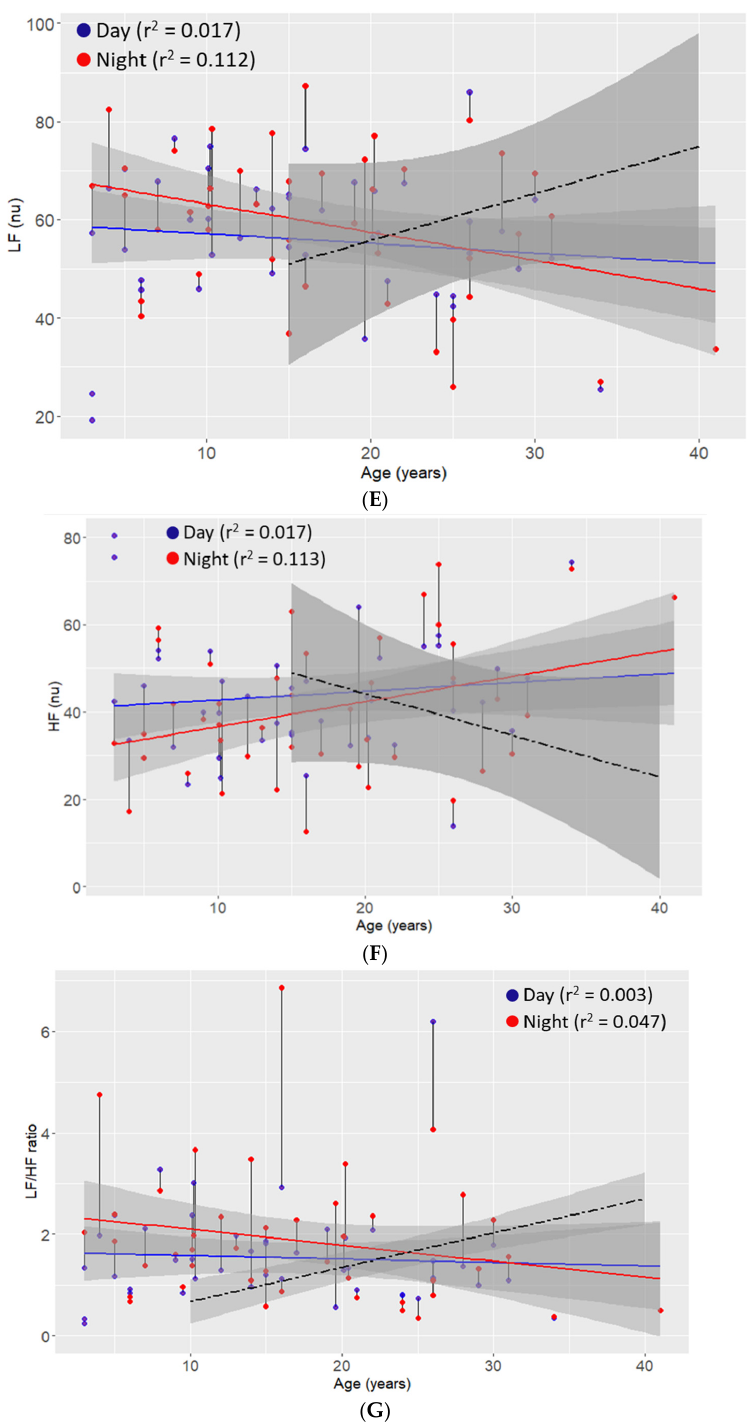
Figure 1. Scatter plots for the different HRV indices (( A ): Mean HR; ( B ): SDNN; ( C ): RMSSD; ( D ): pNN50; ( E ): LF; ( F ): HF and ( G ): LF/HF ratio). Abbreviations: bpm (beats per minute); HF (high frequency); HR (heart rate); LF (low frequency); LF/HF (low frequency/high frequency); Med (median), Min (minimum); Max (maximum); ms (millisecond); nu (normalised units); pNN50 (percentage of successive R-R intervals that differ by more than 50 ms); RMSSD (root mean square of successive differences); SD (standard deviation); SDNN (standard deviation of all NN intervals). Notes: Lines are presented with 95% confidence intervals, and where indicated, norms are presented as a dashed line (see also Supplementary Information